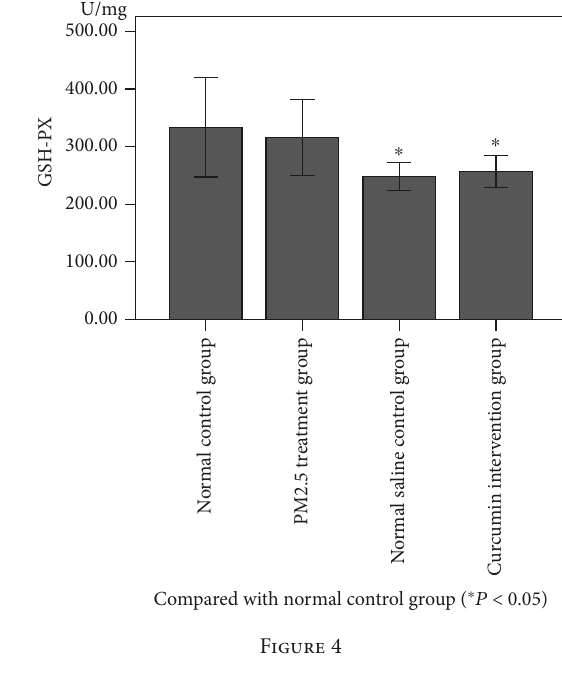
0.001.002.003.004.005.00 T-AOC (units/mg protein) Compared with normal control group ( ⁎ P < 0.05) Normal control group Normal saline control group